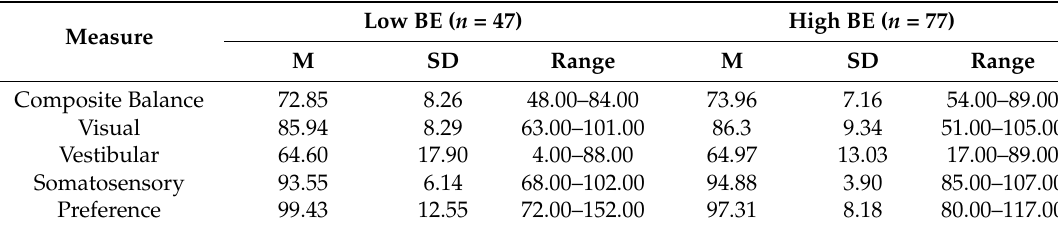
Table 1. Neurocom data descriptives compared with low and high balance efficacy.